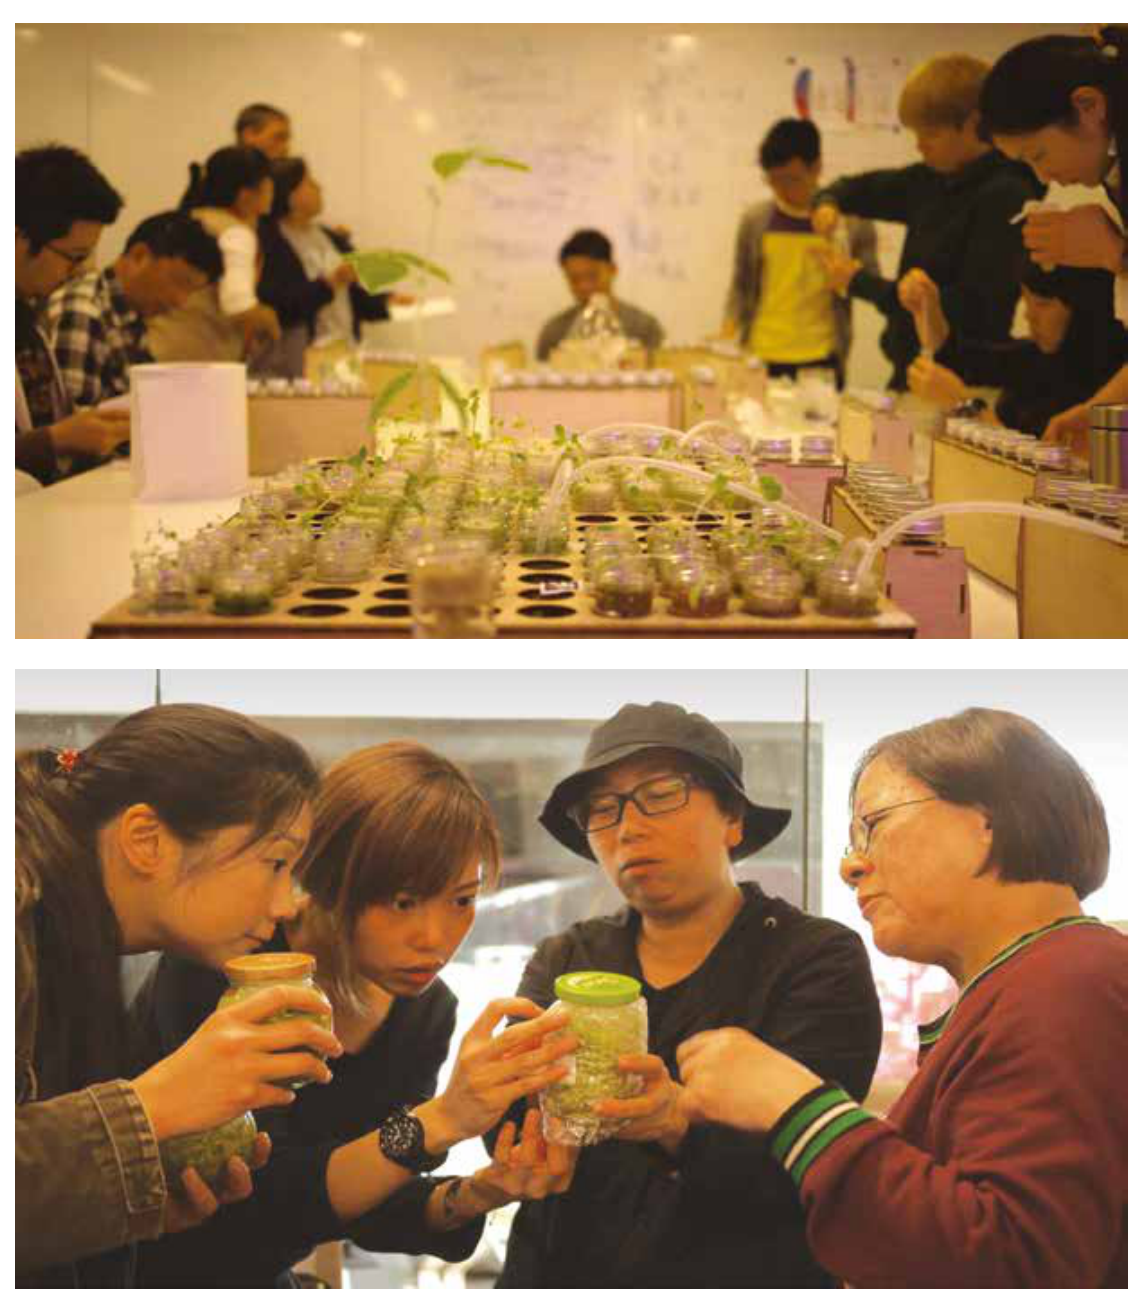
Figures 4 (top) and 5 (bottom): Co-crafting sessions for emergent, self-directed learning. Photographs by Sarah Daher. The five biweekly co-crafting sessions consisted of guided peer- to-peer exchange, lectures to introduce technical concepts, and skill acquisition with simple horticultural contraptions—made up of modular components that were handed out one session at a